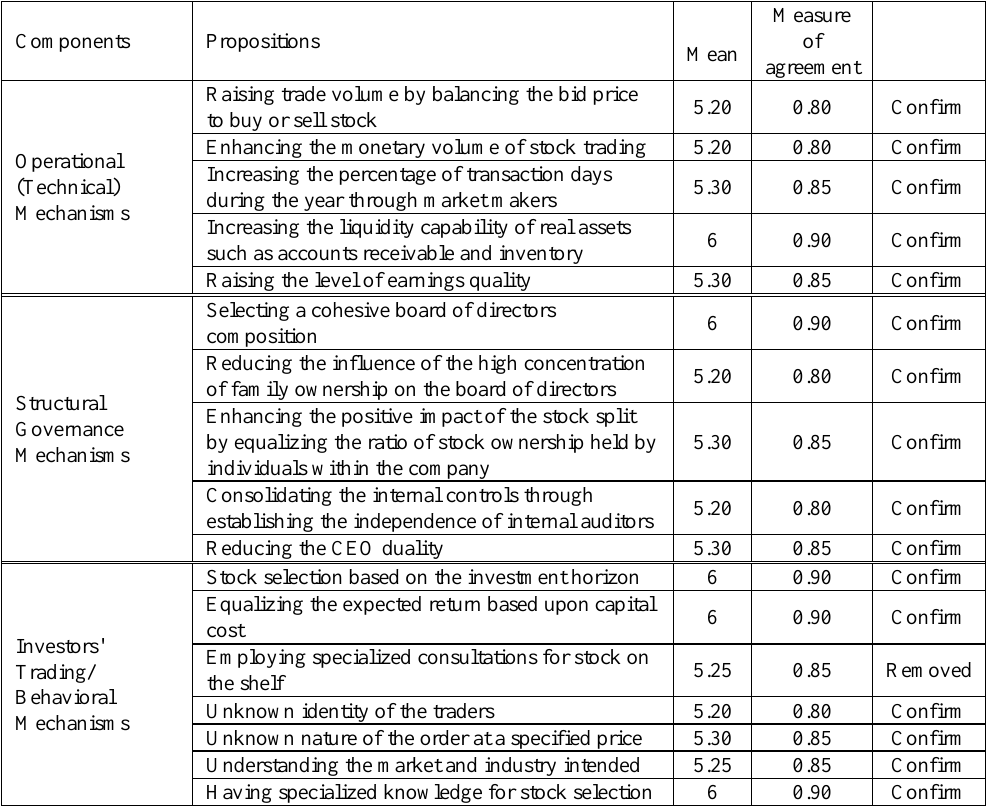
Table 6. The second round of Delphi